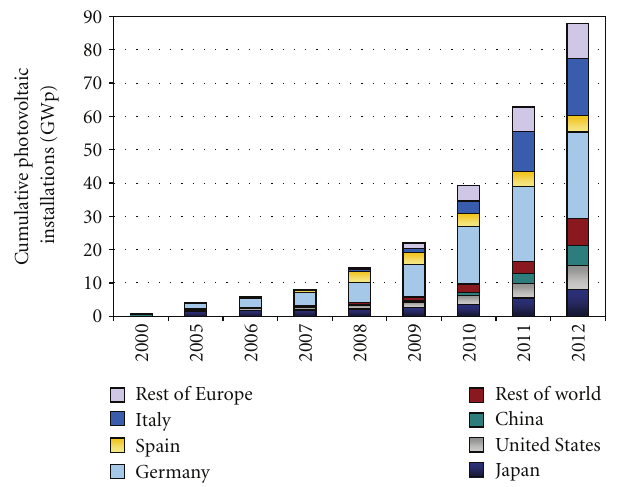
Figure 3: Cumulative photovoltaic installations from 2000 to 2012. 2011 and 2012 are still estimates. (data source: Bank Sarasin [4], EPIA [5], EurObserv’ER [6] and own analysis).